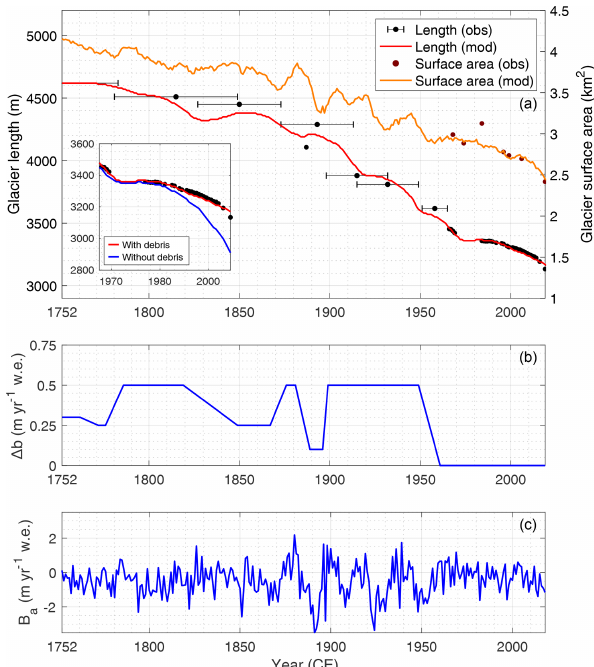
Figure 9. Historic variations of the (a) modelled and observed glacier length and surface area of the Djankuat Glacier until 2017CE, (b) additional mass balance perturbations (cid:49)b used in the dynamic calibration procedure, and (c) reconstructed time series of the total annual mass balance B a of the Djankuat Glacier with changing geometry. Observed length variations are derived from lichenometric dating of moraines in the paleovalley, historic doc- uments, field measurements and/or recent satellite imagery (Bo- yarsky, 1978; Zolotarev, 1998; Petrakov et al., 2012; WGMS, 2018). An additional model run for a 100% clean-ice glacier was con- ducted, which is shown in the box in (a)